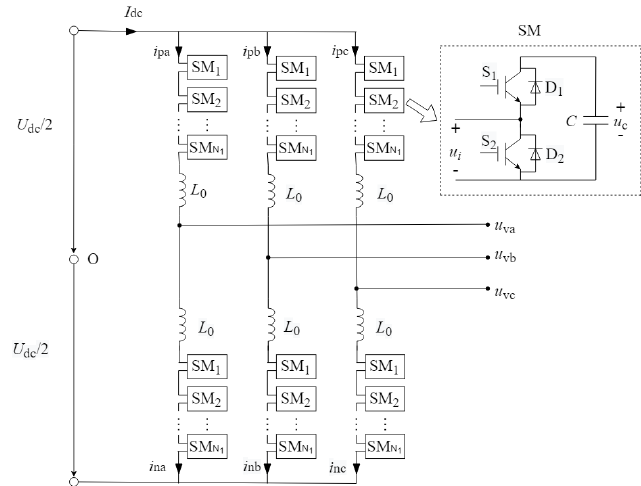
Figure 1. The topology of an MMC inverter.